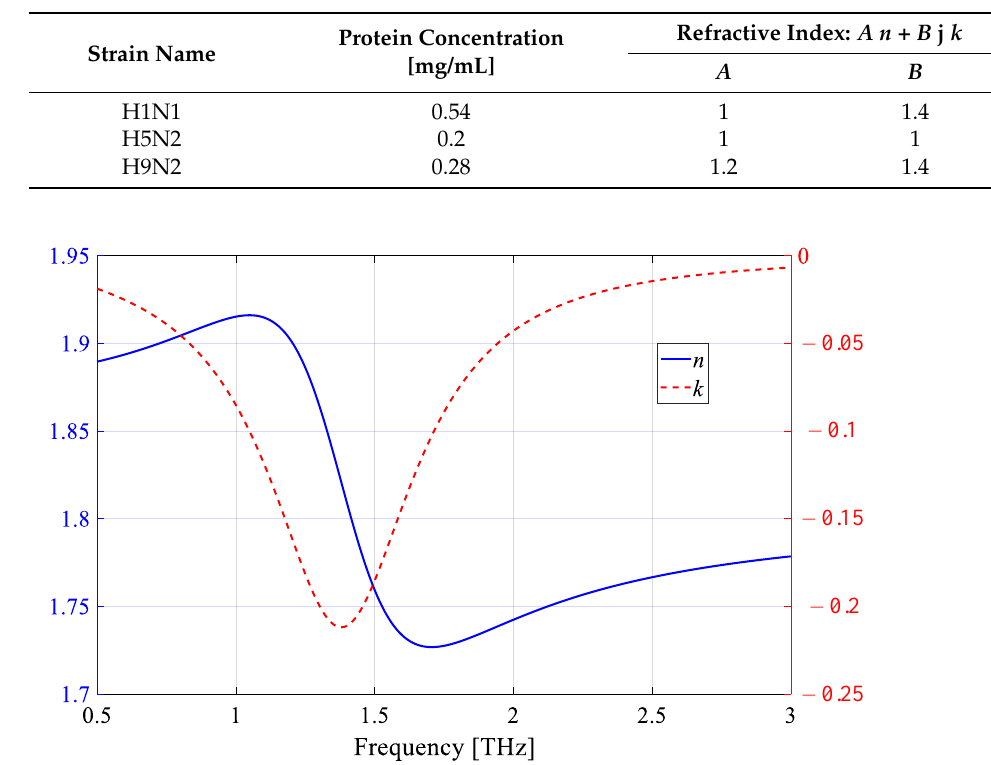
Table 1. Optical properties of three IAV strains for specific protein concentration.